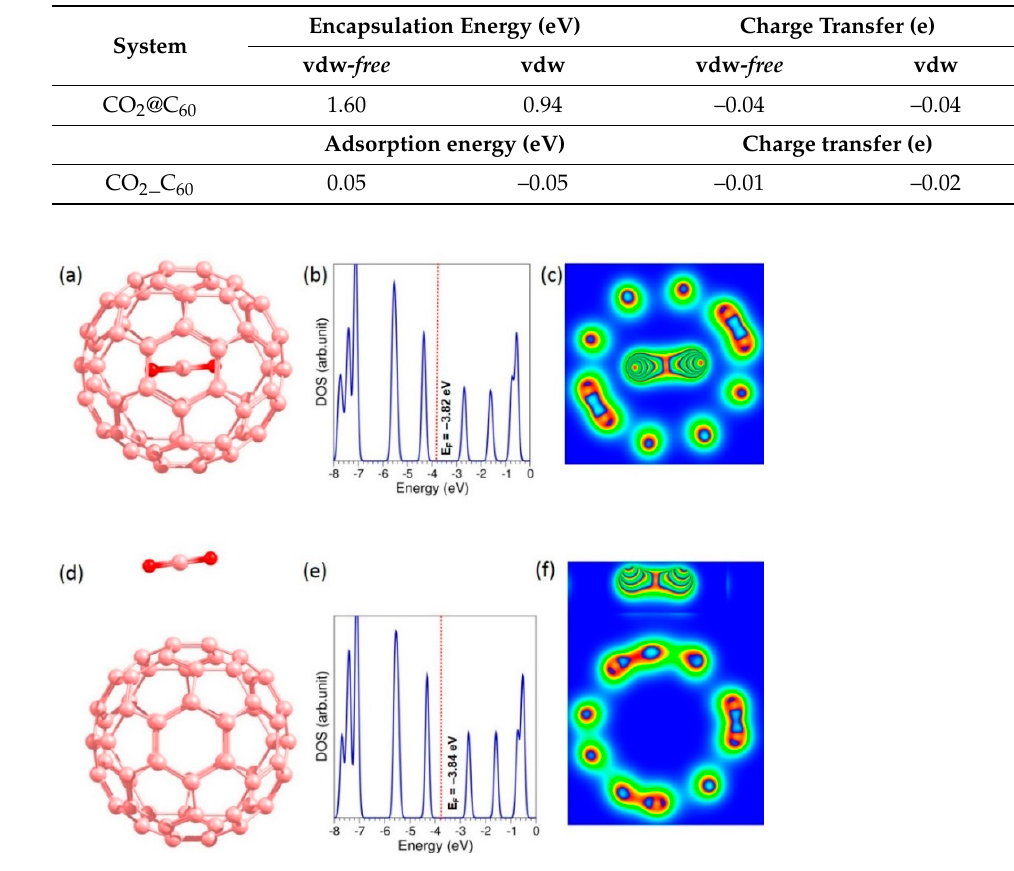
Figure 2. Relaxed structure of ( a ) a CO 2 molecule encapsulated inside the C 60 , ( b ) its DOS plot and ( c ) charge density plot showing no interaction between the molecule and the inner wall of the C 60 . Corresponding information ( d – f ) is also provided for a CO 2 molecule adsorbed on the surface of C 60 .